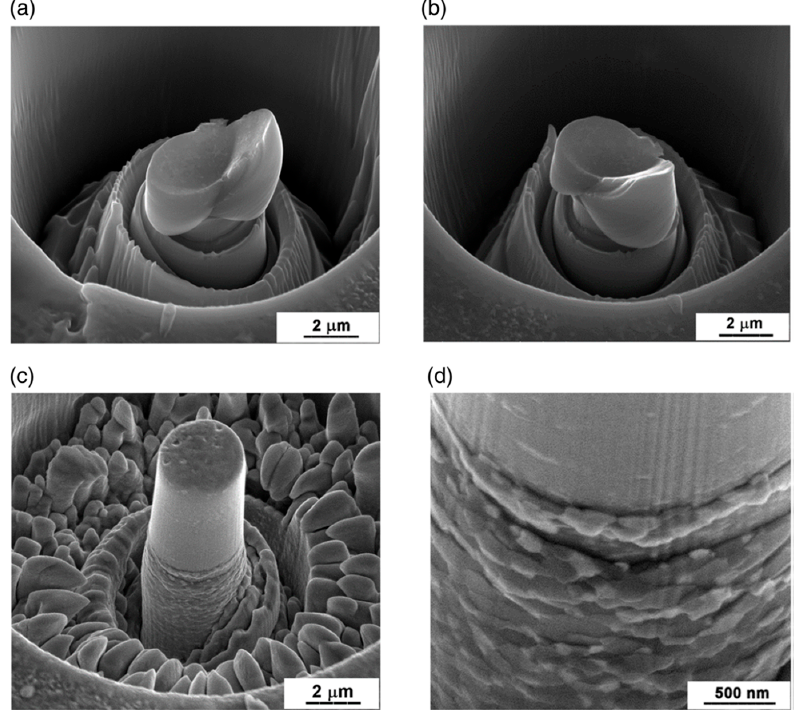
Figure 16. The surface morphologies of ( a , b ) single-crystal Al-30Zn sample in two different positions separated by 60° rotation, showing the well-known extreme slip bands corresponding to the avalanches in sample A in Figure 15, and ( c , d ) ultrafine-grained Al-30Zn sample at different magnifications, indicating intensive grain boundary sliding without strain localizations and extreme slip bands. Reproduced with permission from [68]. Copyright 2014, Wiley.